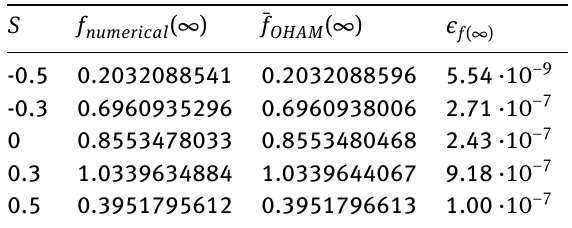
Table 8: Comparison between the mass transfer coefficient ¯ φ ′ (0) obtained by means of the OHAM and numerical results, for S = −0.5 , λ = 0.1 and different values of the Schmidt coefficient Sc